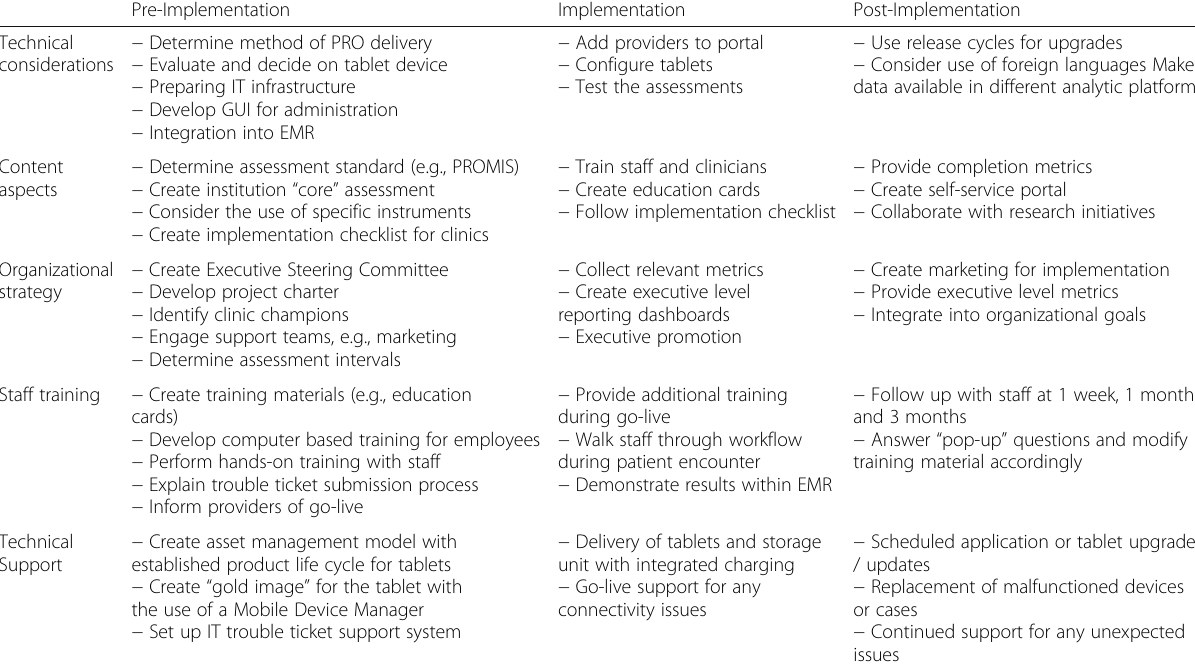
Table 1 Barriers and facilitators for each of the three implementation phases: pre-implementation, implementation, and post-implementation Pre-Implementation